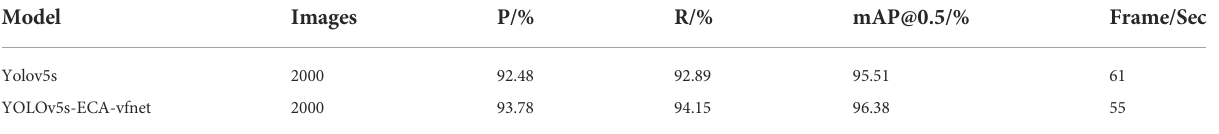
TABLE 2 Comparison with the YOLOv5s.